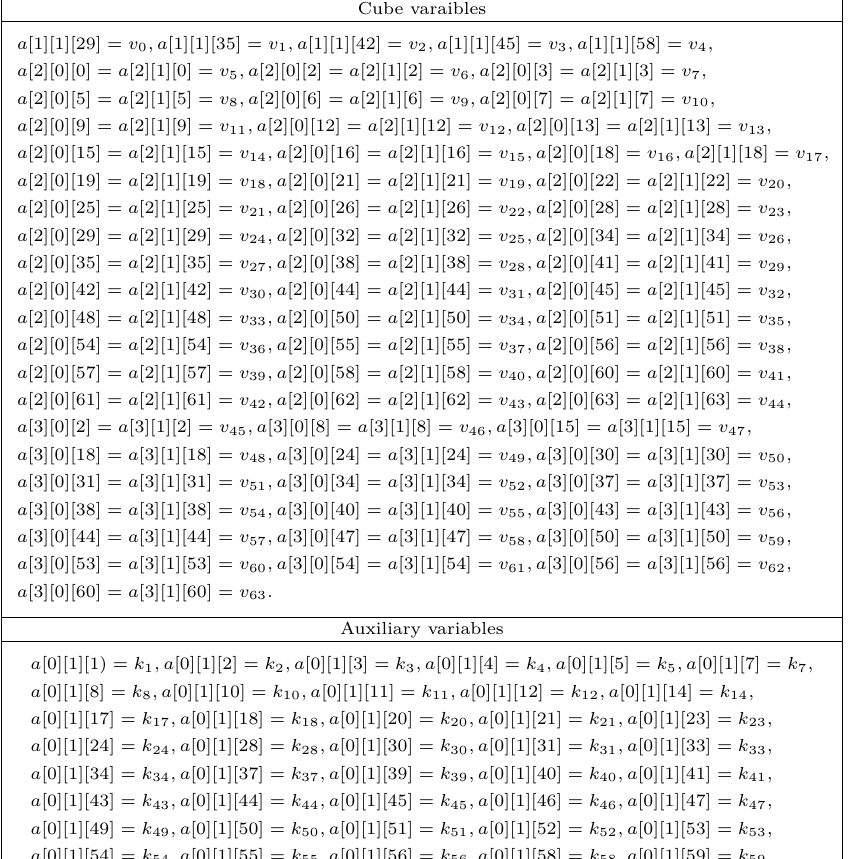
Table 16: A 64-dimensional cube for Keccak -MAC-512, where ( n a , n i ) = (46 , 46). In total, there are 92 bits key information involved in both auxiliary variables and involved key bits. Cube